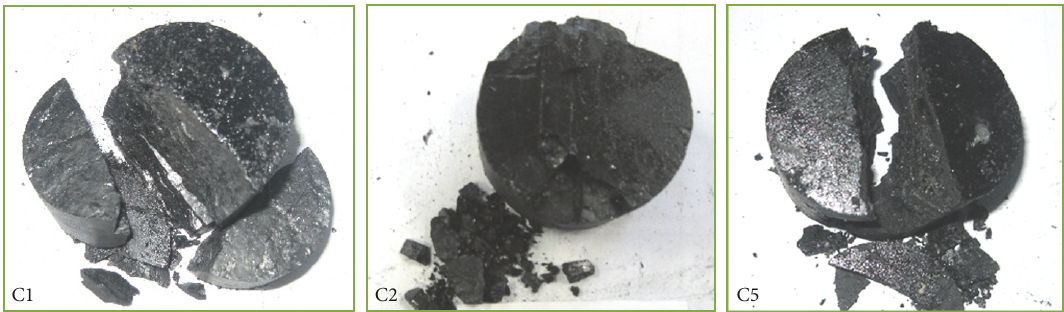
Figure 16: Failure forms of natural and water-saturated specimens under triaxial static loads.